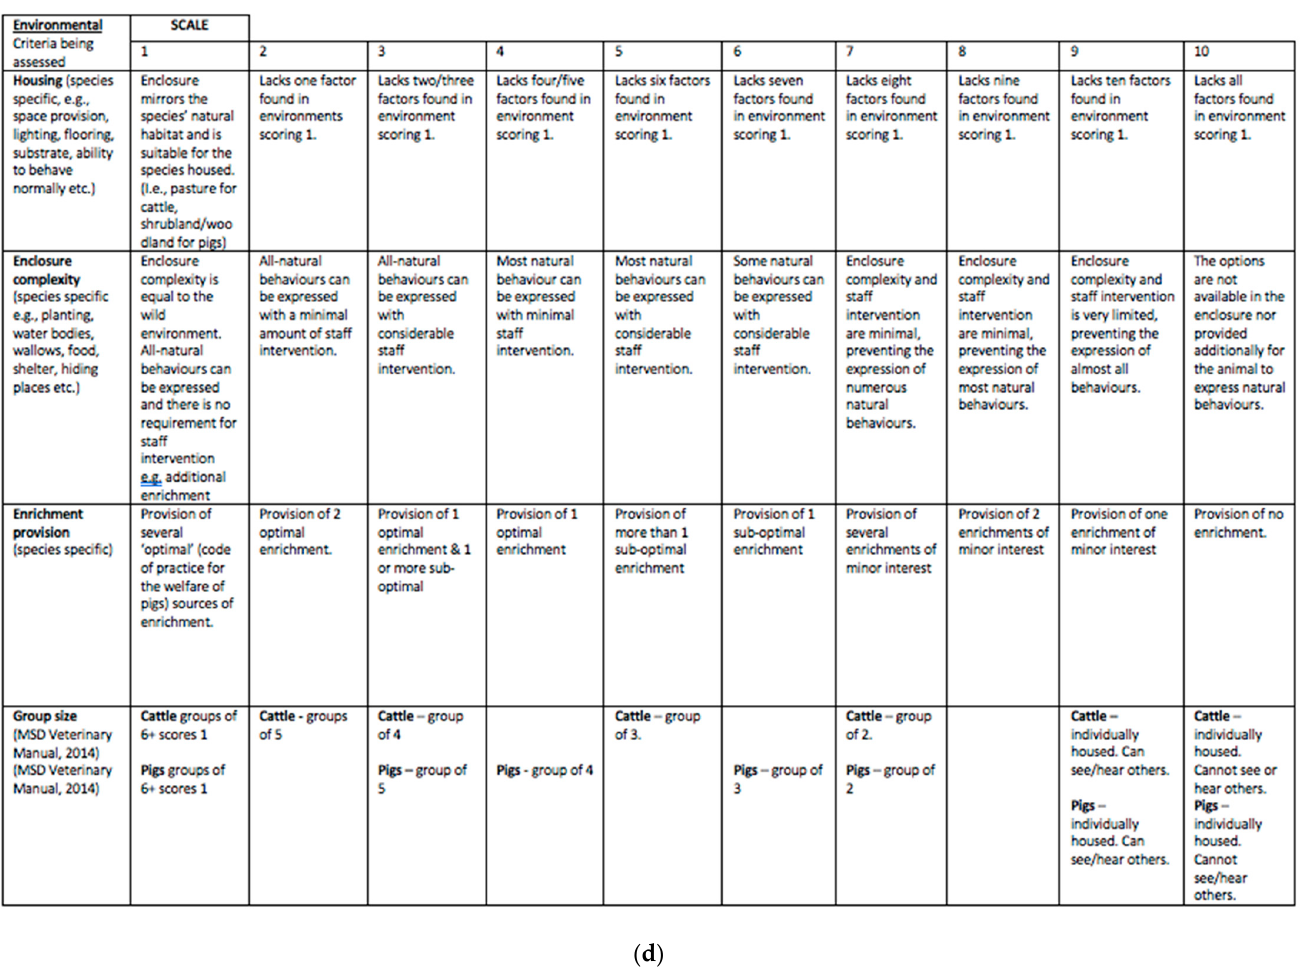
Figure A1. Criteria Tables for Each Factor. ( a ) Criteria table for scoring of physical factors. ( b ) Criteria table for scoring of procedural factors.; ( c ) Criteria table for scoring of psychological factors; ( d ) Criteria table for scoring of environmental factors.